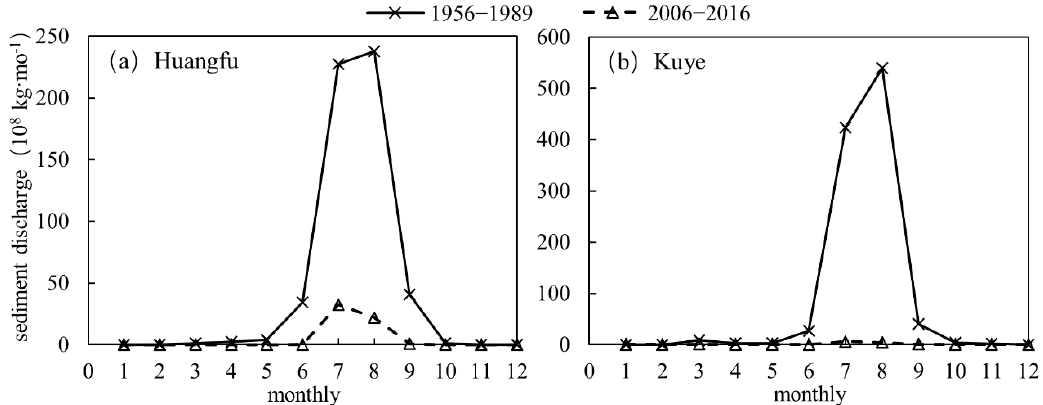
Figure 4. Variations of monthly average sediment discharge in the Huangfu basin ( a ) and the Kuye basin ( b ).